Question: Which kind of chart has been used to present this data?
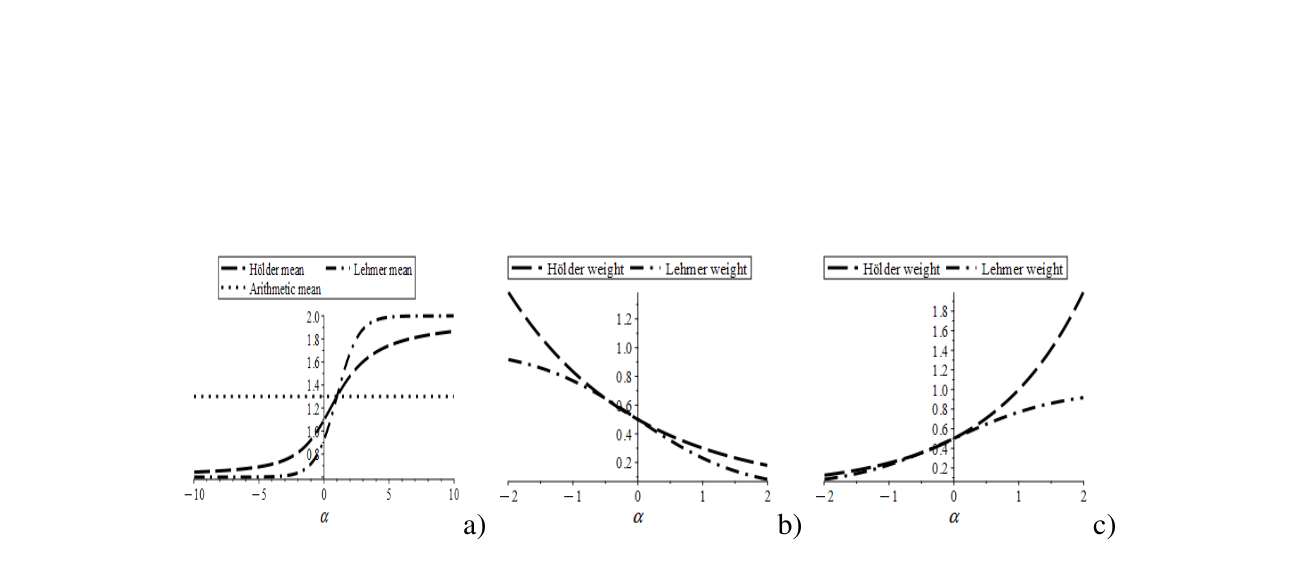
Answer: line